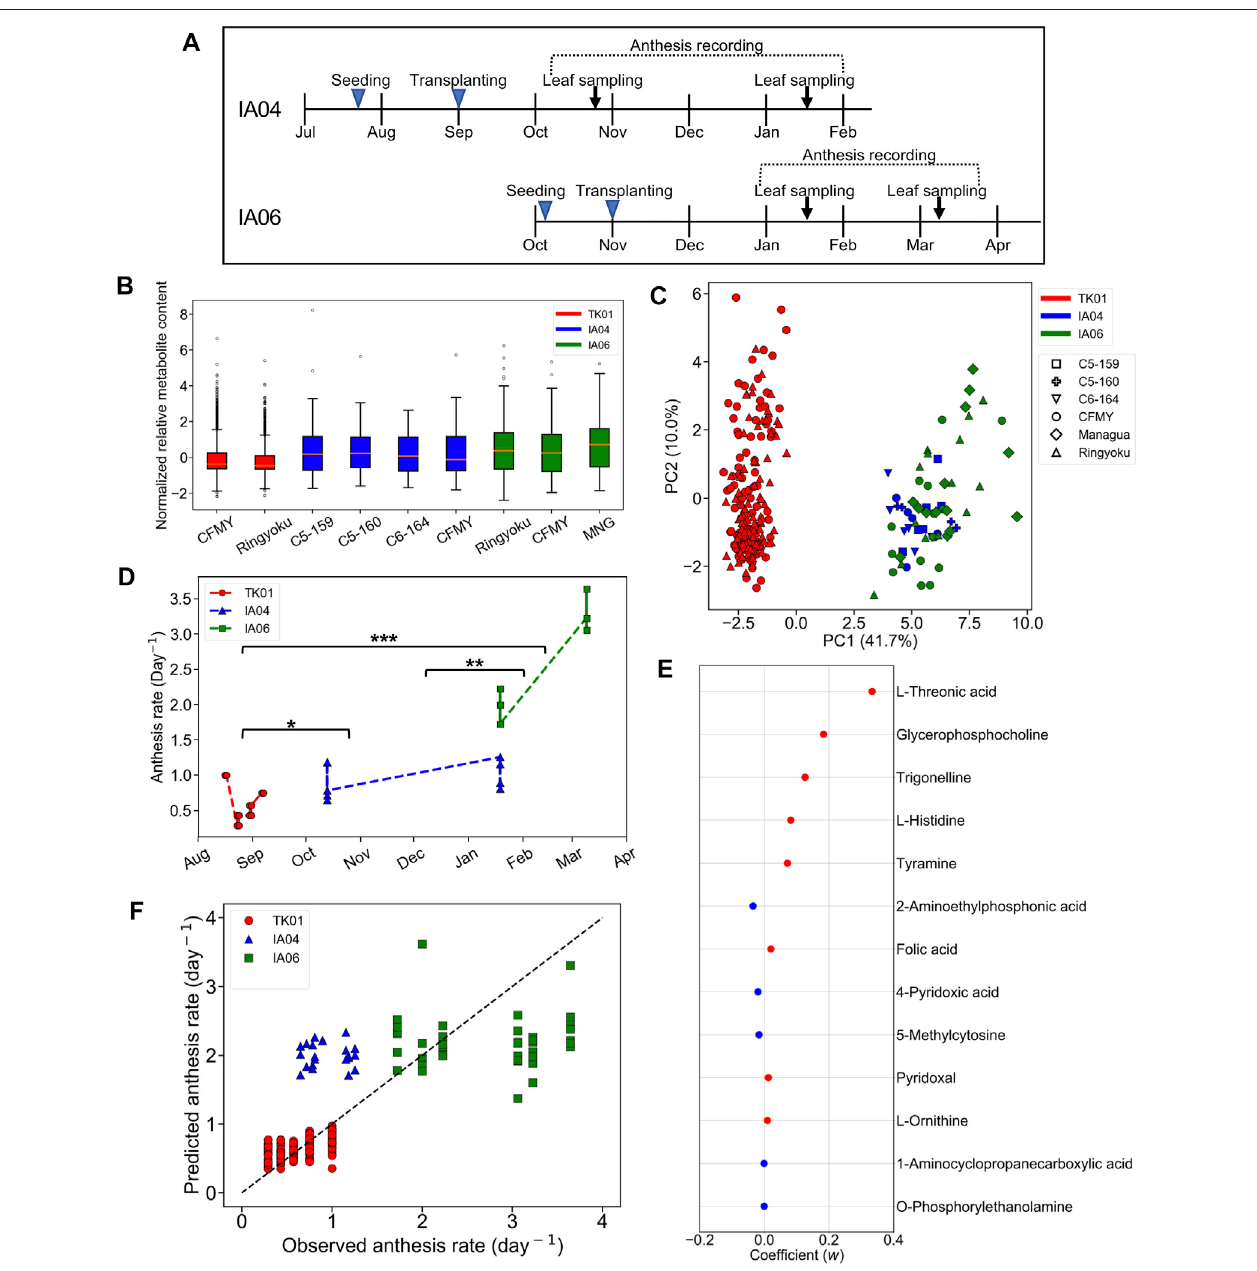
FIGURE 3 | Predictability assessment of the 29 predictor metabolites with expanding metabolome datasets. (A) Experimental timeline for leaf sampling and anthesis measurements in IA04 (cultivars: CFMY, C5-159, and C5-16) and IA06 (cultivars: CFMY, Ringyoku, and MNG). (B) Box plot of standardized relative metabolite contents of the 29 predictor metabolites in each cultivar in three experimental designs (TK01, IA04, and IA06). The numbers of leaf samples ( n ): CFMY ( n = 96) and Ringyoku( n =96)inTK01,CFMY( n =6),C5-159( n =6),C6-164( n =6),andC5-160( n =4)inIA04,andRingyoku( n =14),CFMY( n =14),andManagua( n =14)in IA06. (C) PCAscoreplotofleafsamples( n =256)byusingmetabolicpro fi lesofthe29predictormetabolitesfromthreeexperimentaldesigns(TK01,IA04andIA06).The contribution ratio is shown in parentheses for the fi rst and second principal component (axis). The colors indicate the experimental designs, and the markers represent the cultivars. (D) Anthesis rates used for the LASSO model (TK01, n = 16; IA04, n = 8; IA06, n = 6). Asterisks indicate signi fi cant differences according to the Kruskal- WallistestwithConover ’ smultiplecomparisontest(*, p < 0.05;**, p < 0.01;and***, p < 0.001). (E) Modelcoef fi cients( w )of13metabolitesselectedintheLASSOmodel construction with metabolome datasets from three experimental designs (TK01, IA04 and IA06). The red dots are positive coef fi cients, while the blue dots are negative coef fi cients. (F) Comparison of anthesis rates between observed and predicted values obtained from the model constructed by the three datasets. The dotted line represents the agreement between the observed and predicted